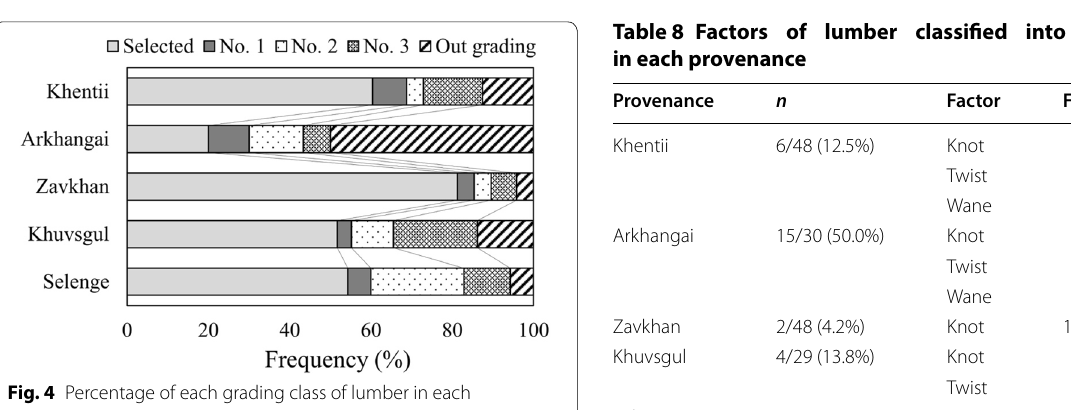
n : number of outgrading lumber/total number of lumber (percentage of outgrading